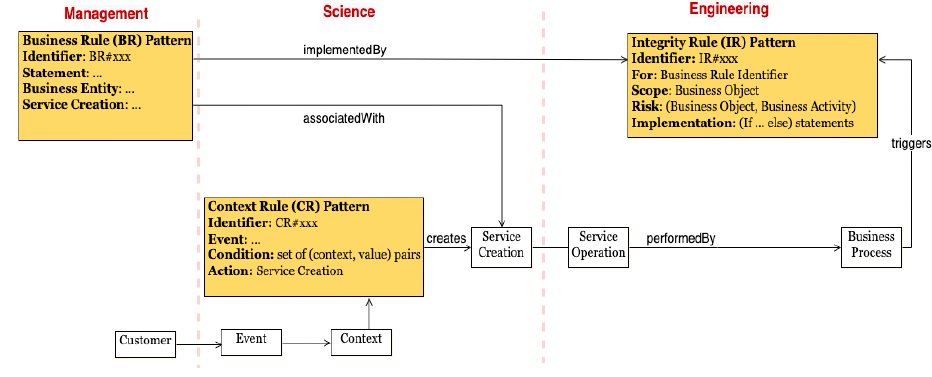
Fig. 2. RuCBS patterns’ relationships for an explicit event